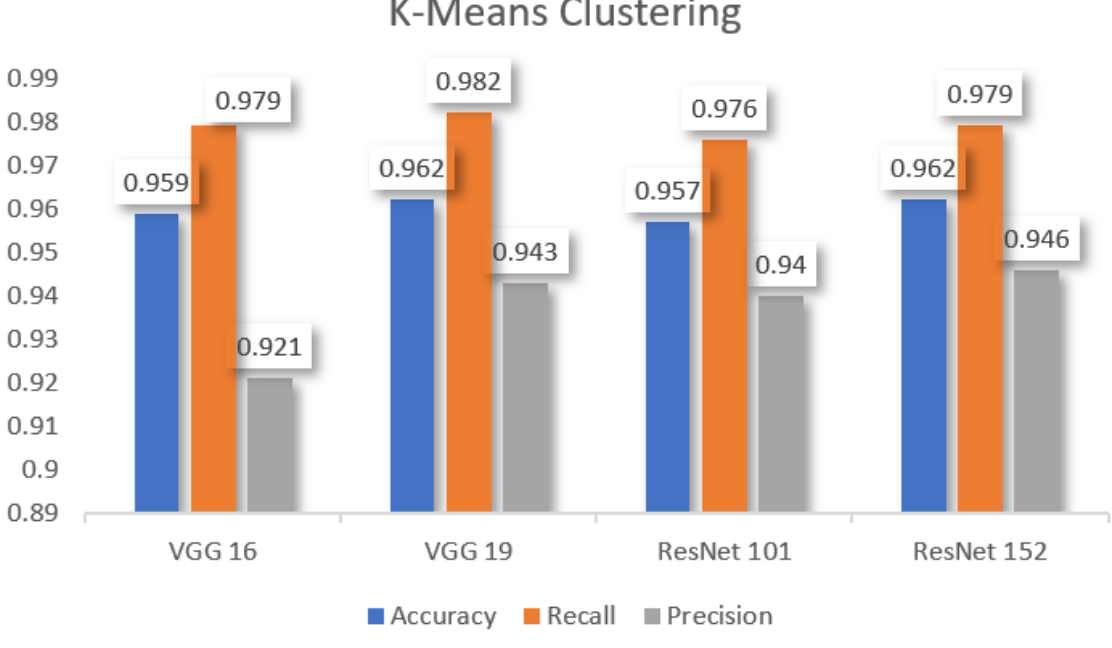
Figure 16. Comparative analysis of the performance metrics among various models using k-means clustering.